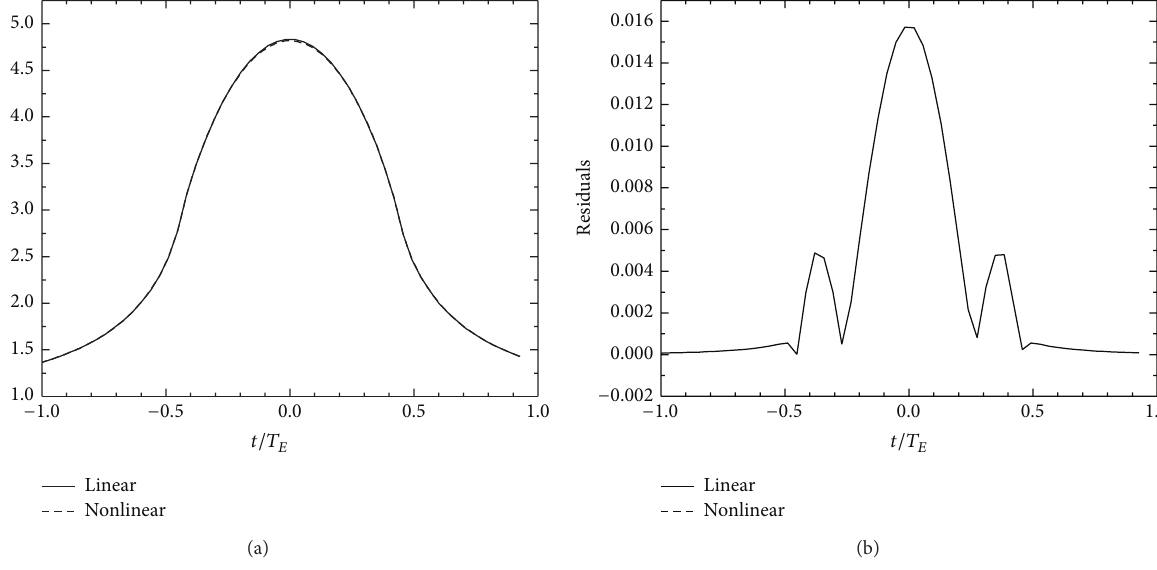
Figure 3: (a) Time variation of the amplification for a microlensing event ( 𝑢 0 = 0.1 , 𝜌 ∗ = 0.46 ) with linear LDC ( 𝑈 = 0.6866 ) (continuous line) and with four-parameter nonlinear power law ( 𝑎 1 = 0.7181 , 𝑎 2 = −0.5941 , 𝑎 3 = 1.1698 , and 𝑎 4 = −0.4558 ) (dashed line). (b) The residual curve between the two curves is shown. The time is given in units of the Einstein time of the